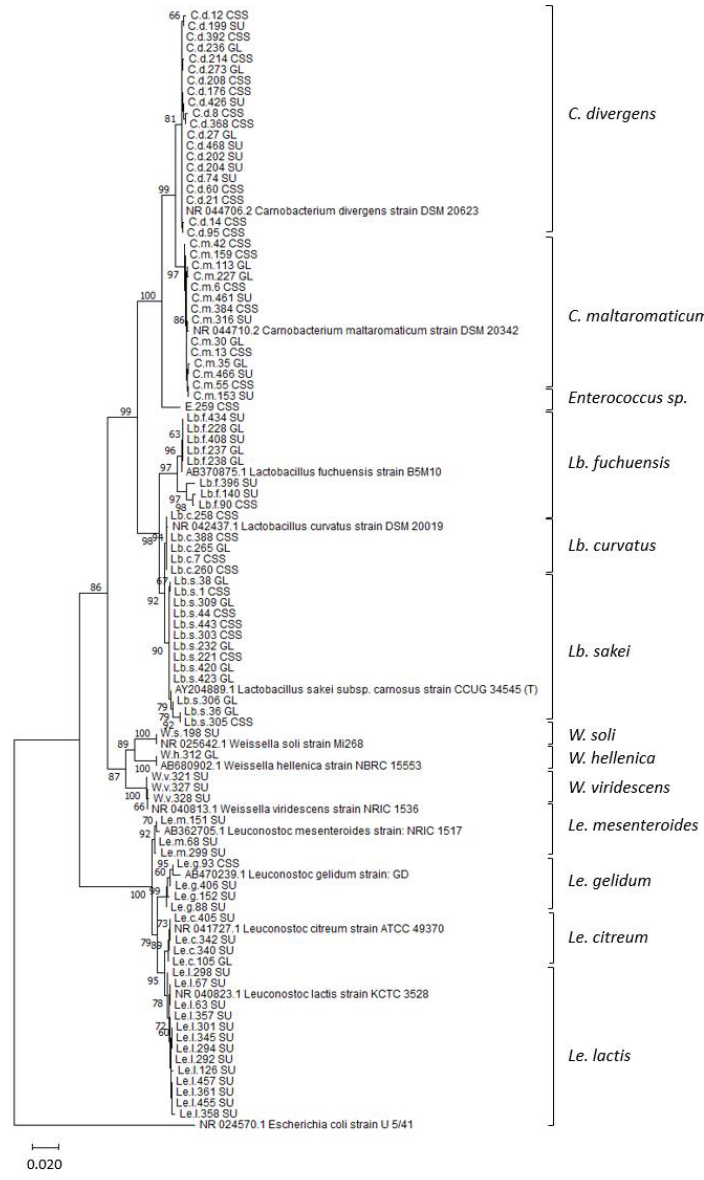
Figure 2. Neighbor-joining tree based on partial 16S rRNA gene sequences of lactic acid bacteria isolated from sushi (SU), cold-smoked salmon (CSS), and gravlax (GL). The evolutionary distances were computed using the maximum composite likelihood method. Reference sequences retrieved from the GenBank database are indicated with gene bank accession numbers. The percentage of 1000 bootstrap replicates is shown next to the branches (only values >50% are shown). The scale bar indicates an evolutionary distance of 0.02 nucleotide substitutions per site. The analysis included 103 sequences and a total of 1124 positions in the final dataset. Escherichia coli (acc. no NR024570) was used as an outgroup.